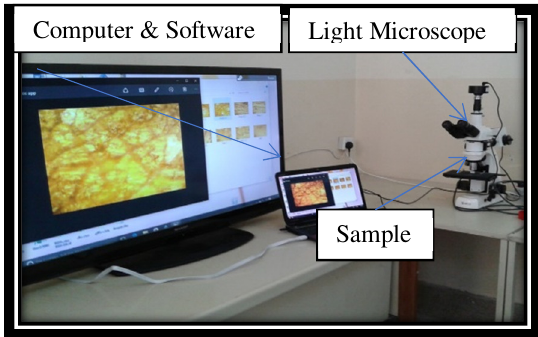
Fig. 6. Rockwell Hardness Testing Machine